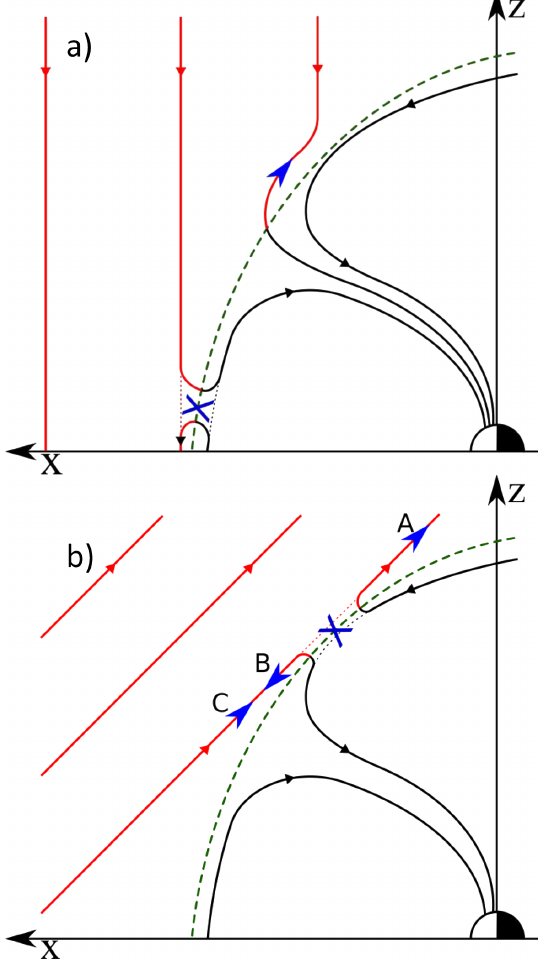
Figure 2. Illustrations showing typical reconnection events and cor- responding magnetic topology for southward (a) and northward (b) respectively. The green dashed line corresponds to an approximate magnetopause, the red magnetic field lines correspond to IMF lines, the black corresponds to geomagnetic field lines, and the small ar- rows indicate field direction. The larger blue arrows correspond to different paths that ions entering the dayside magnetosheath may take.